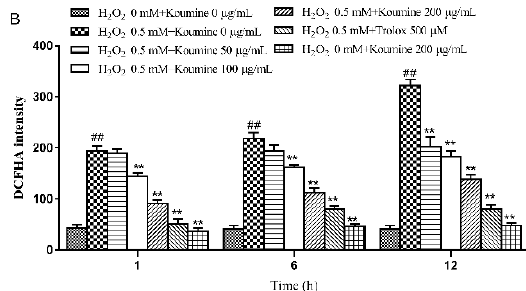
Figure 5. Effect of koumine on H 2 O 2 -induced release of ROS in IPEC-J2 cells (mean ± s.d., n = 5) Legend: ## indicate level of significance at p < 0.01, respectively, compared with the control group; ** indicate level of significance at p < 0.01, respectively, compared with the oxidative stress model group. ( A ) Intracellular ROS level was stained with DCFH-DA and detected by flow cytometry; ( B ) Quantified expression of ROS in the IPEC-J2 cells.